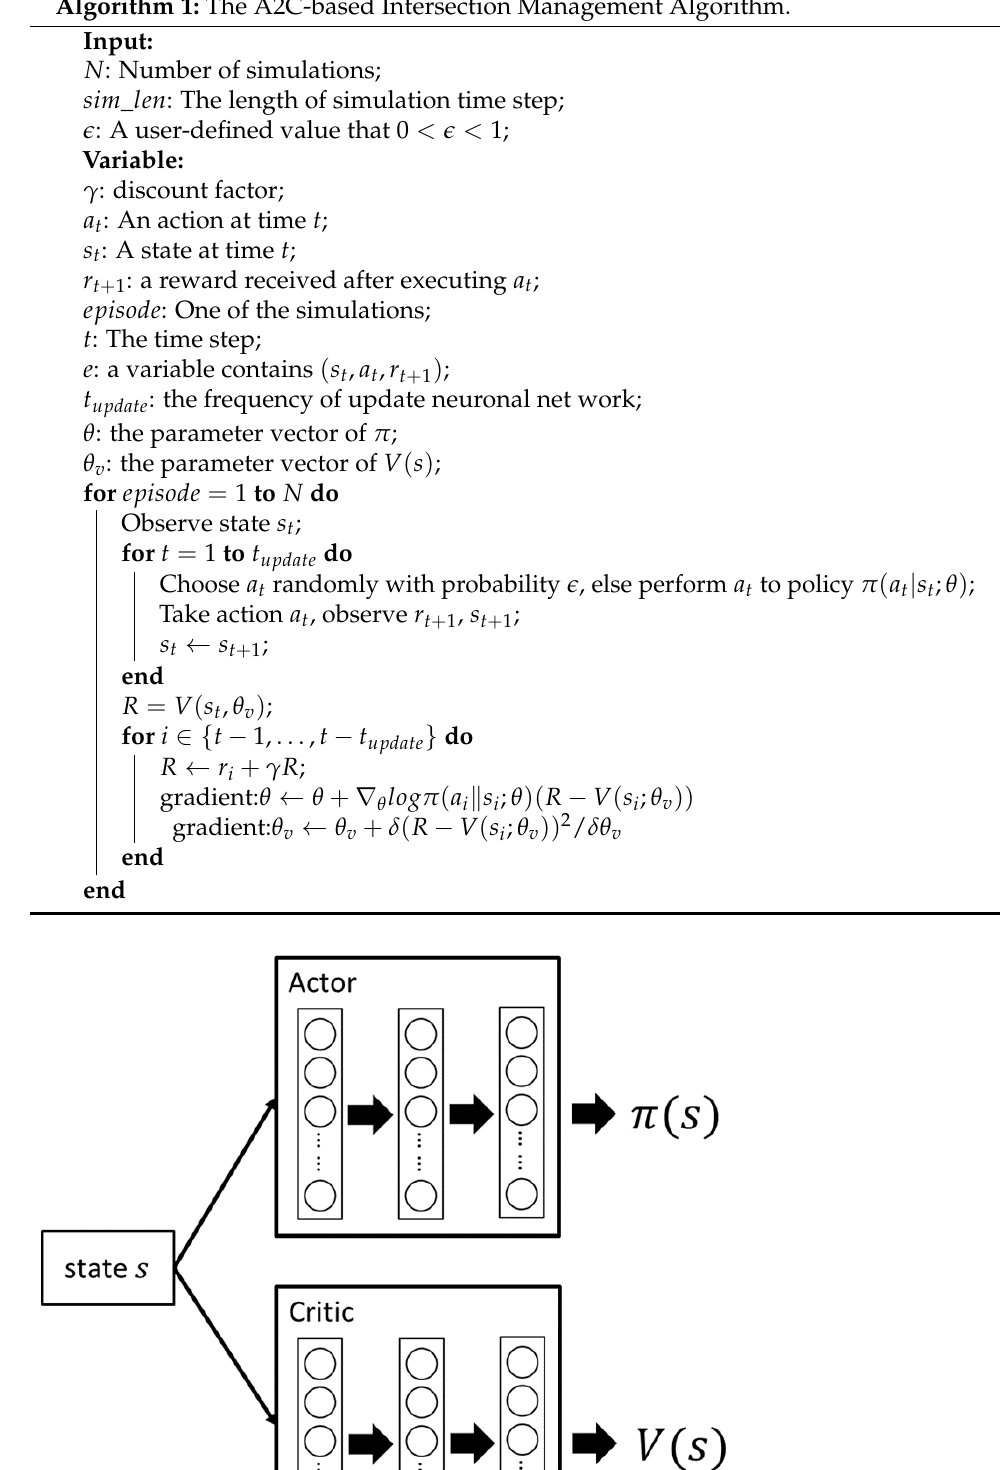
Algorithm 1: The A2C-based Intersection Management Algorithm.